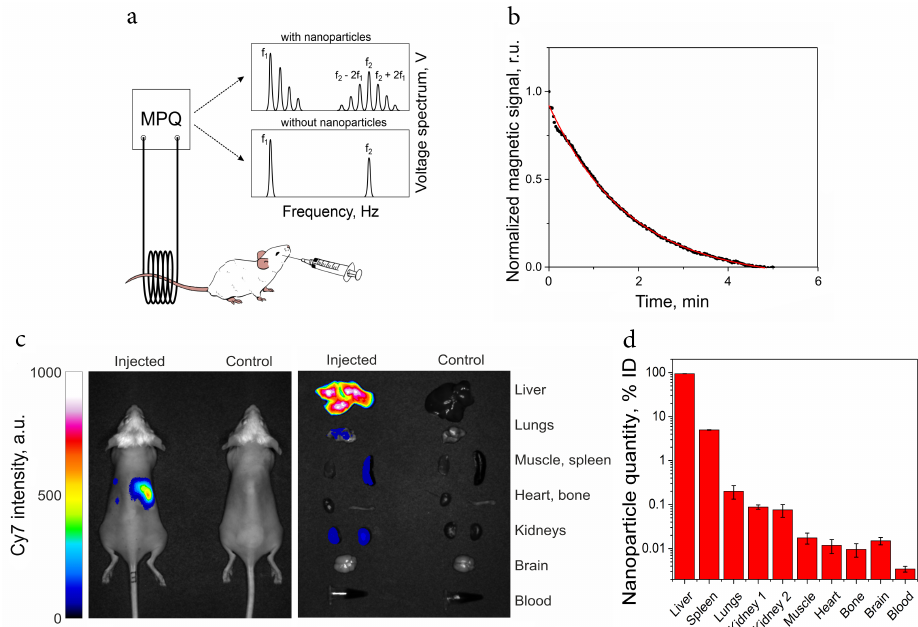
Figure 6. Circulation time and biodistribution of the composite in mice. Schematic representation of circulation dynamics measurements with MPQ device ( a ); representative circulation kinetics for 300 µ g of DopSucCy7@Ferria measured by the MPQ method. Black dots correspond to the magnetic signal of the device at certain time points; the red curve corresponds to the exponential fitting curve ( b ); in vivo and ex vivo fluorescent images superposed with bright field images of a control animal (right) and injected with DopSucCy7@Ferria (left), λ ex = 730 nm and λ em = 780 nm ( c ); biodistribution of the composite measured with the MPQ technique ( d